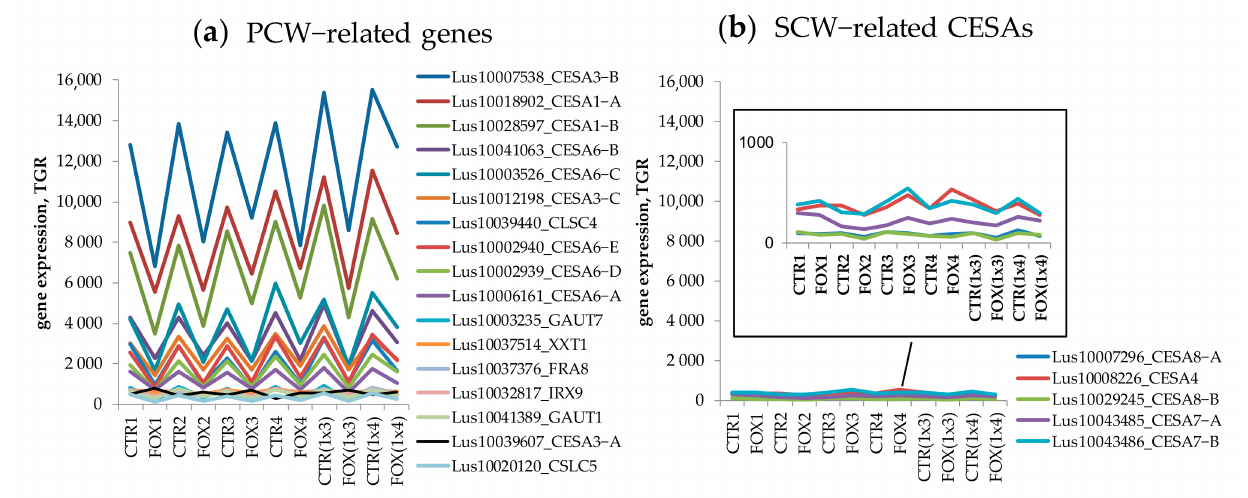
Figure 3. The expression of genes encoding cell-wall related biosynthetic enzymes during the infection by Fusarium oxysporum . ( a ) The expression of genes encoding products involved in primary cell wall (PCW) biosynthesis. ( b ) The expression of genes encoding cellulose synthases (CESAs) involved in the secondary cell wall (SCW) formation.